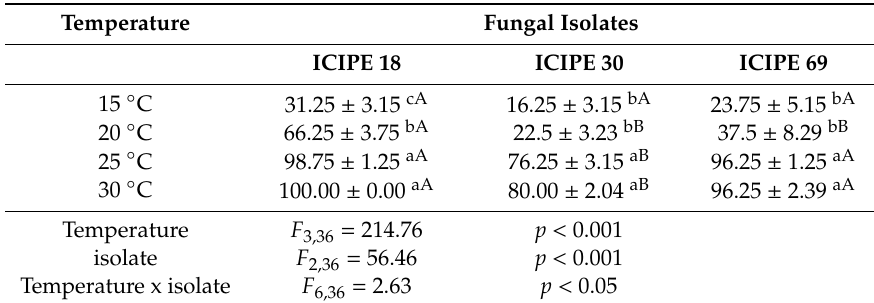
Table 3. Percentage mortality of adult Z. cucurbitae caused by M. anisopliae isolates at di ff erent temperature regimes at 4 days’ post-exposure.